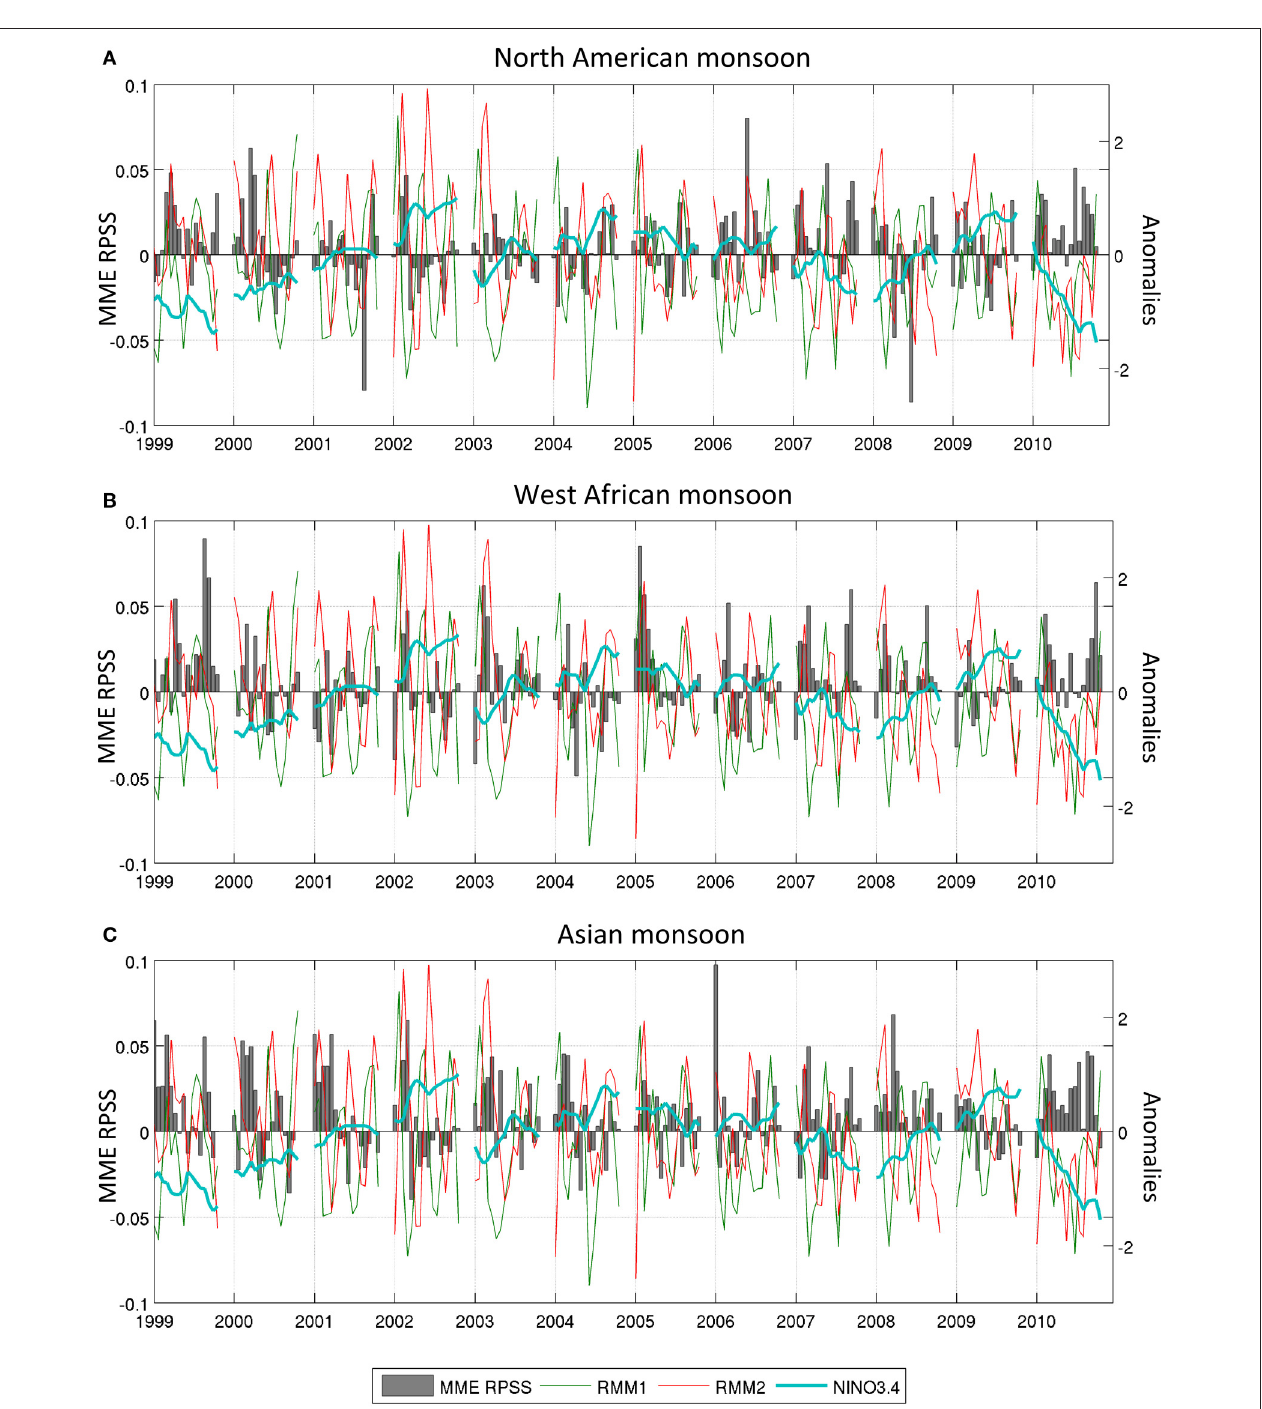
FIGURE 11 | MME Week 3–4 RPSS averaged over the North American (A) , West African (B) , and Asian (C) continental monsoon regions (bars) together with observed Niño3.4 index (cyan) and MJO measured by the RMM1 (green) and RMM2 (red) indices of Wheeler and Hendon (2004). Corresponding correlations can be found in Table 2